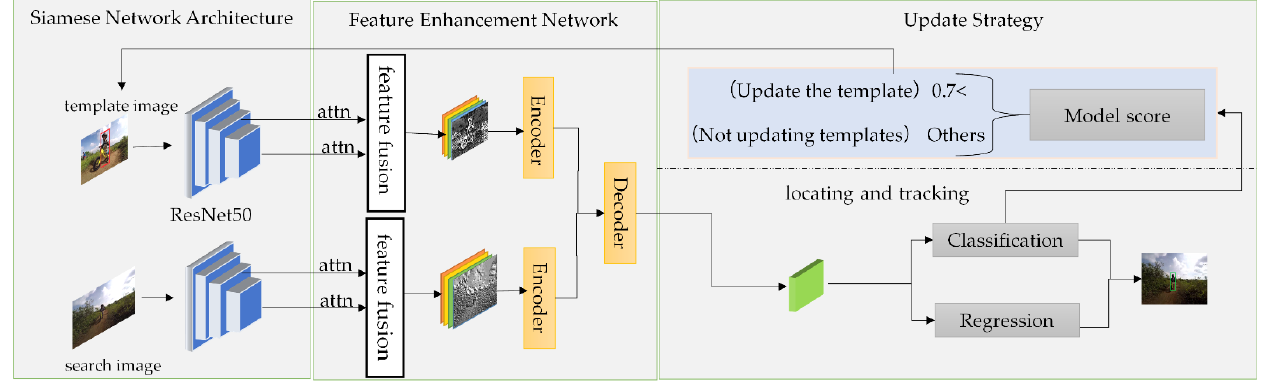
Figure 1. Overall framework of object tracking method based on transformer feature enhancement network with template update. network with template